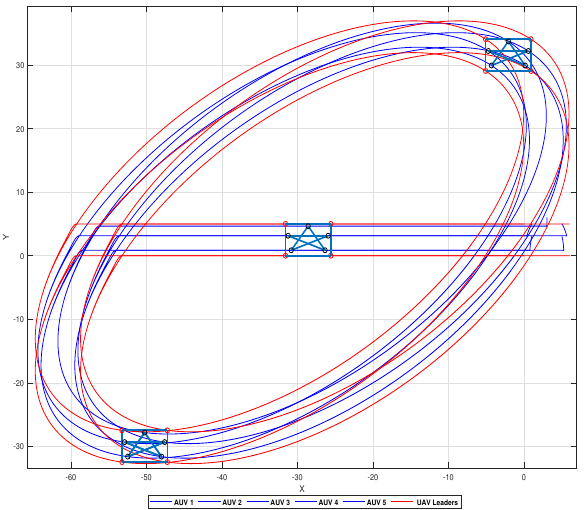
Figure 9. The containment control of five AUVs in star formation within their four UAVs leaders in square formation without disturbance and uncertainty in 2D